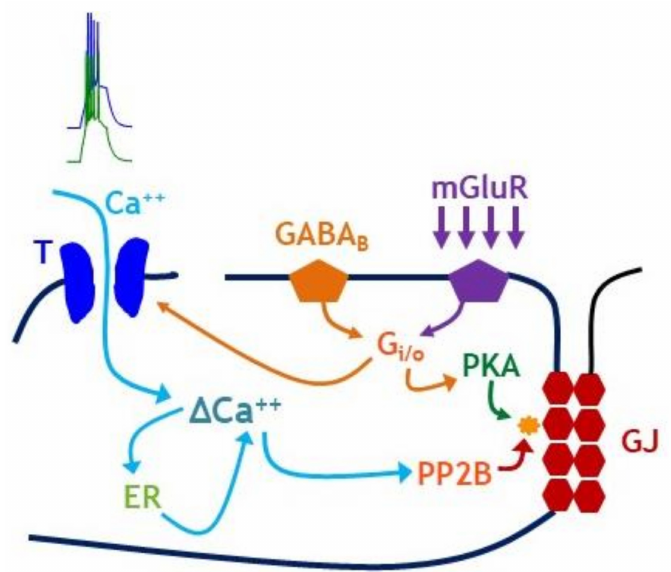
Figure 8. Proposed interactions between GABA B receptors and established LTD pathways. LTD of electrical synapses can be induced by paired bursting (left; [31]) or by mGluR tetanization (right; [15]). Our results indicate that GABA B receptors interacts with both burst-induced and mGluR-induced signaling pathways. We propose that burst-induced LTD requires GABA B receptor activation to maintain its calcium dependence. ACPD-induced plasticity reverts to its underlying LTP mechanisms in the absence of GABA B receptor activation. Burst-induced LTD and ACPD-induced LTD are both blocked by GABA B receptor saturation of PKA at the endpoint of